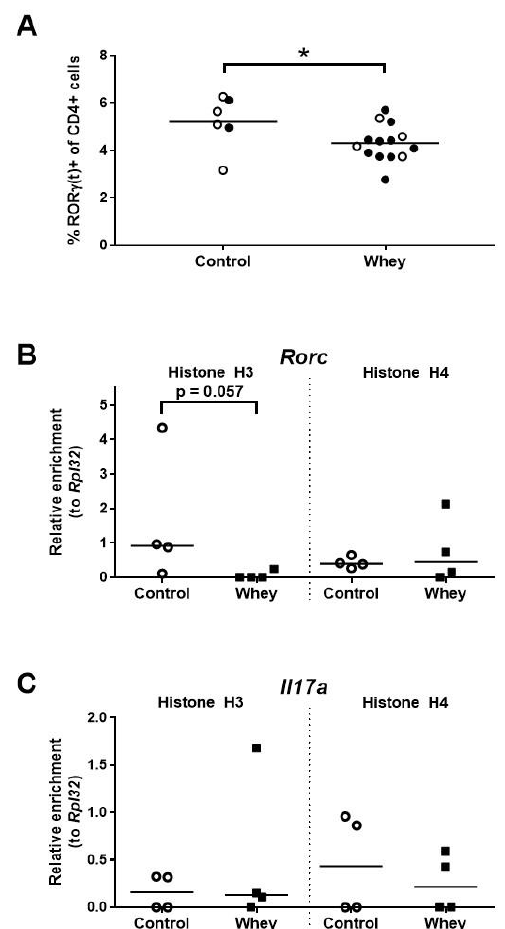
Figure 5. A confirmed allergic response to whey protein reduced the percentages of spleen Th17 cells and tended to decrease H3 histone acetylation levels at the promoter responsible for transcription of ROR γ t. ( A ) The percentage of CD4 + T cells positive for ROR γ (t) as assessed by flow cytometry. Data are presented as a scatter dot plot showing individual data points and mean. Open circles indicate the mice that were included in the histone modification analysis. Data of one mouse in the control group were excluded due to a technical error. Comparisons were performed with an unpaired t test. Histone acetylation levels at the promoter responsible for the transcription of ROR γ t (i.e., isoform 2) from the RAR-related orphan receptor γ encoding gene ( Rorc ) ( B ) and the interleukin 17A gene ( Il17a ) ( C ) in spleen-derived CD4 + T cells as determined by chromatin immunoprecipitation followed by qPCR. Data are presented as scatter dot plots showing individual data points and median. Comparisons were performed with a Mann–Whitney U test. * p < 0.05; p -values ≥ 0.05 and < 0.2 are shown as numbers. 3.5. A Confirmed Allergic Response to Whey Protein Tended to Reduce the Percentage of Treg Cells in the Spleen and Decreased Histone Acetylation Levels at the Promoter of the Interleukin 10 Gene Analysis of the percentages of the CD4 splenocytes characterized by a Treg phenotype—as assessed by positivity for forkhead box P3 (Foxp3), a Treg lineage master transcription factor [41,42]—demonstrated a tendency towards a lower percentage of Tregs in whey-sensitized mice versus control mice (Figure 6A). However, no e ff ect was seen on the histone acetylation pattern of Foxp3 (Figure 6B). The levels of histone acetylation at the promoter of Il10 , a gene encoding the hallmark Treg cytokine, tended to be lower in the whey-sensitized mice than in the controls (Figure